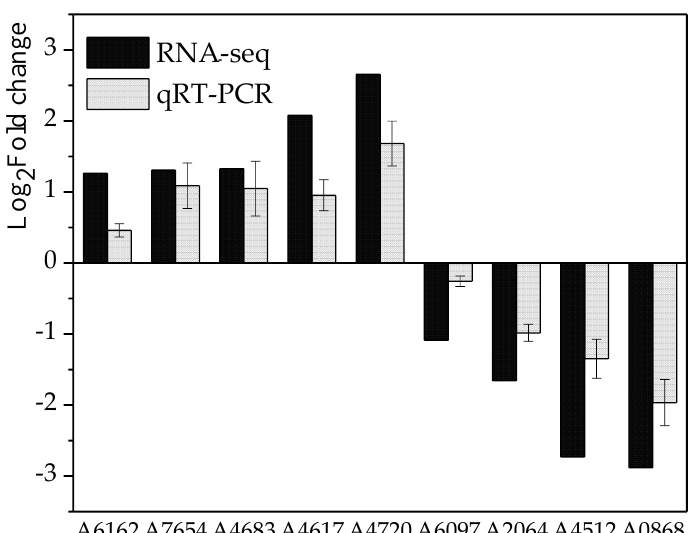
Figure 3. Comparison of the gene expression levels from transcriptomic data and qRT-PCR.